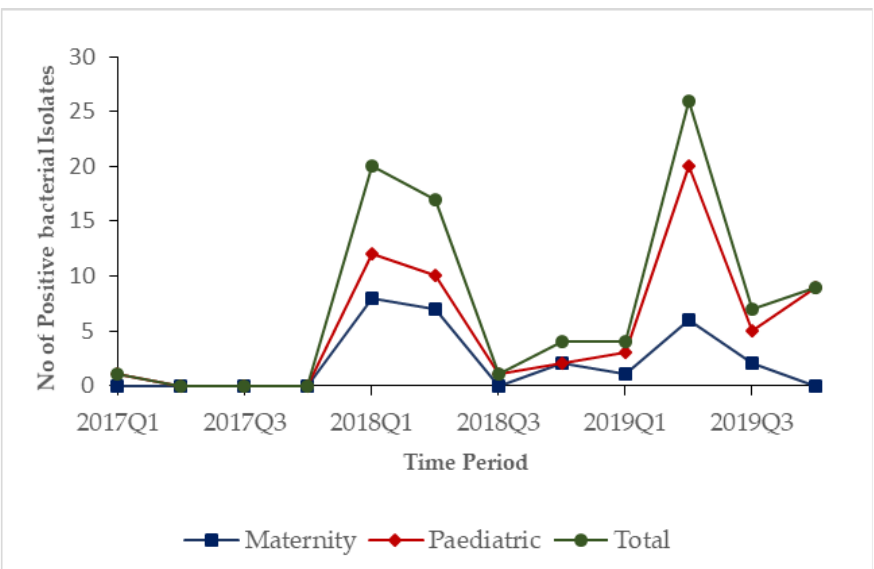
Figure 1. Quarterly trends of lab samples that showed bacterial growth stratified by hospitals in Freetown, Sierra Leone, from 2017 – 2019. Table 2. Factors associated with antimicrobial resistance among cultures with bacterial growth from two referral hospitals in Freetown, Sierra Leone from 2017 to